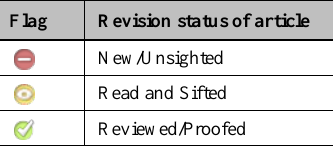
Figure 6. Traffic light flags in